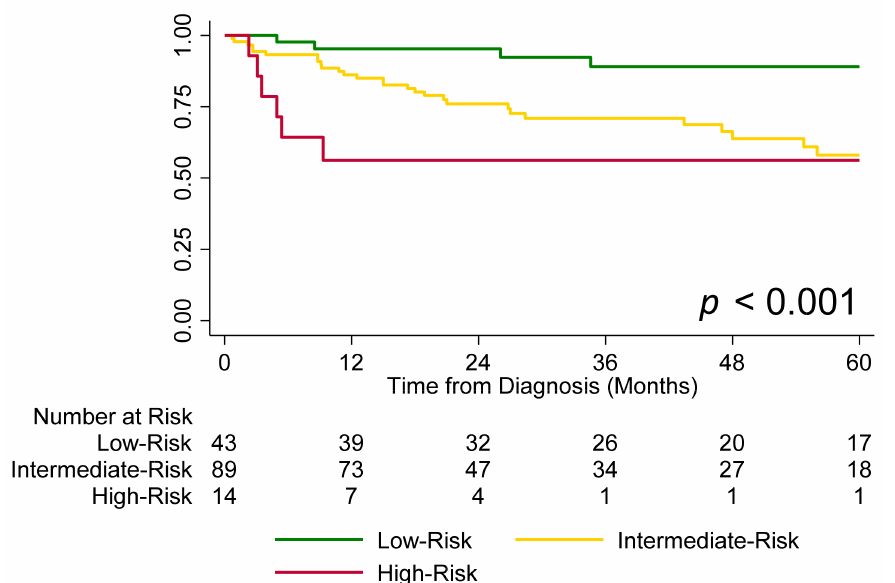
Figure 1. Transplant-free survival by risk group (low vs. intermediate vs. high).